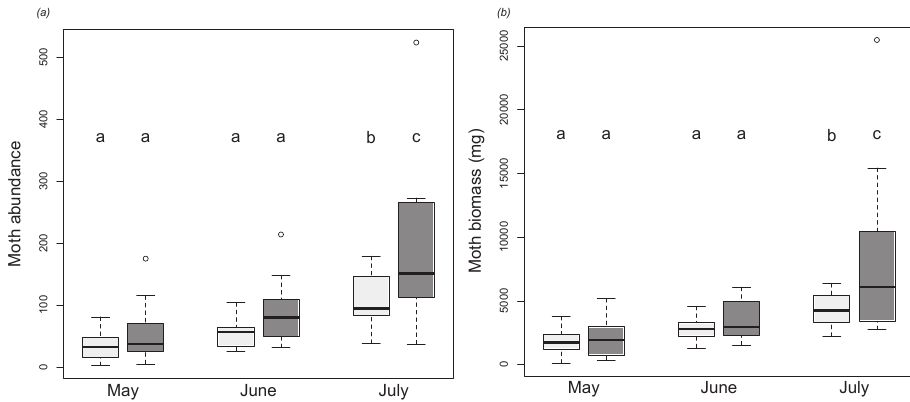
Figure 2. Moth abundance a and moth biomass b increased in occupied (dark grey) and abandoned sites (light grey) from May to July. The boxplots indicate the 25%, 50% (bold line) and 75% limits of moth biomass, whiskers the 10% and 90% deciles. The open dot indicates an outlier. Statistically significant differences, depicted by different letters on column tops, occurred only in July.